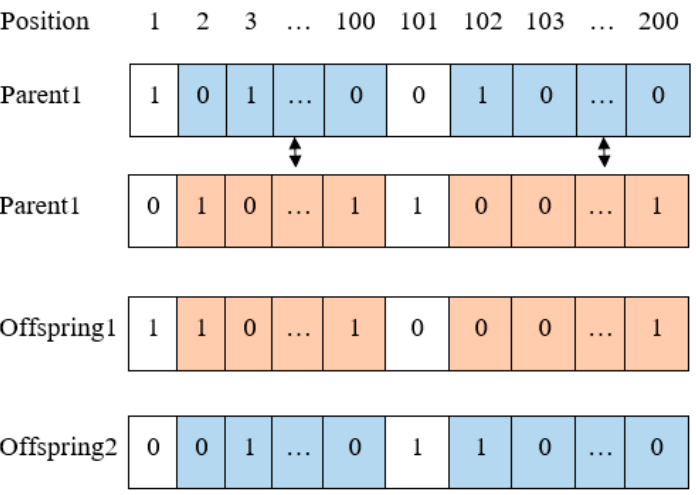
Figure 6. An example of crossover.